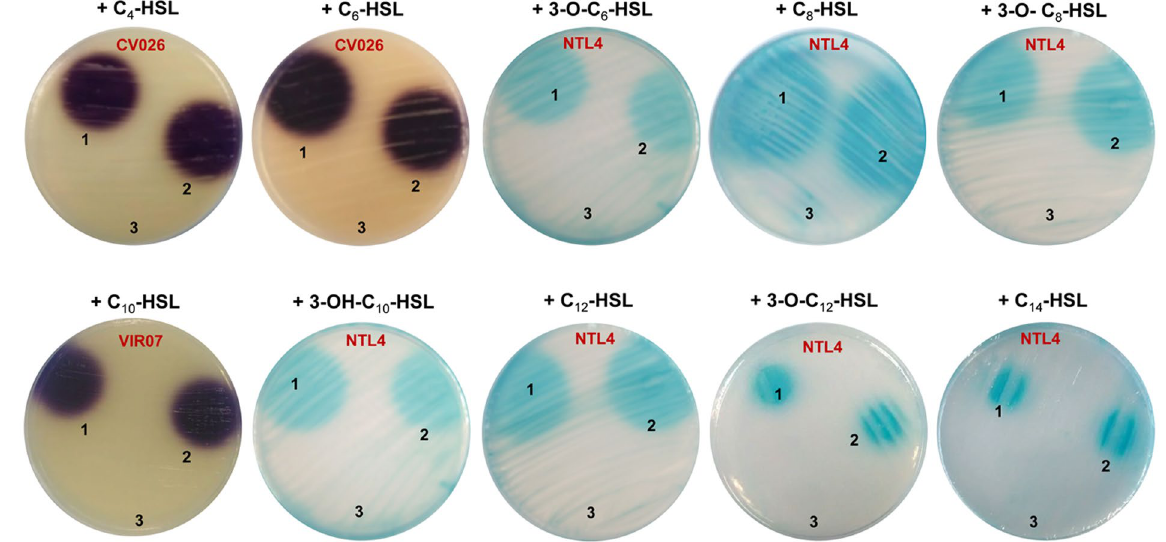
Figure 1. Diffusion agar-plate assay to detect AHL degradation using the biosensors Chromobacterium violaceum CV026, C . violaceum VIR07 and Agrobacterium tumefaciens NTL4 (pZLR4). Cell-free LB medium (1), E . coli S17 λ pir (2) and E . coli S17 λ pir harbouring the fosmid f10/17.1H (3) were supplemented with the same quantities of C 4 -HSL, C 6 -HSL, 3-O-C 6 -HSL, C 8 -HSL, 3-O-C 8 -HSL, C 10 -HSL, 3-OH-C 10 -HSL, C 12 -HSL, 3-O-C 12 -HSL and C 14 -HSL.